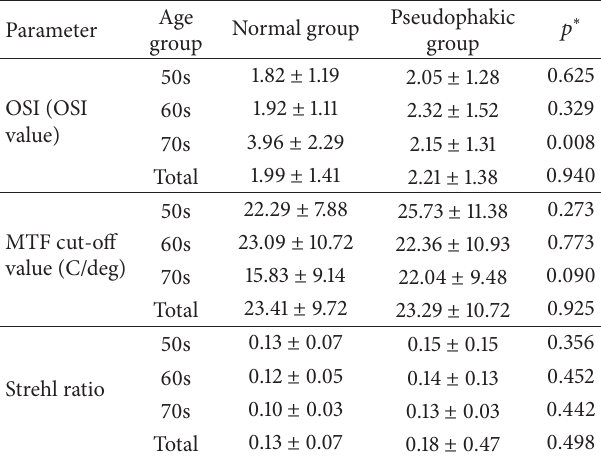
Table 5: OQAS parameters (mean ± SD) of normal ( 𝑁 = 93 ) and pseudophakic ( 𝑁 = 143 ) eyes, stratified by age